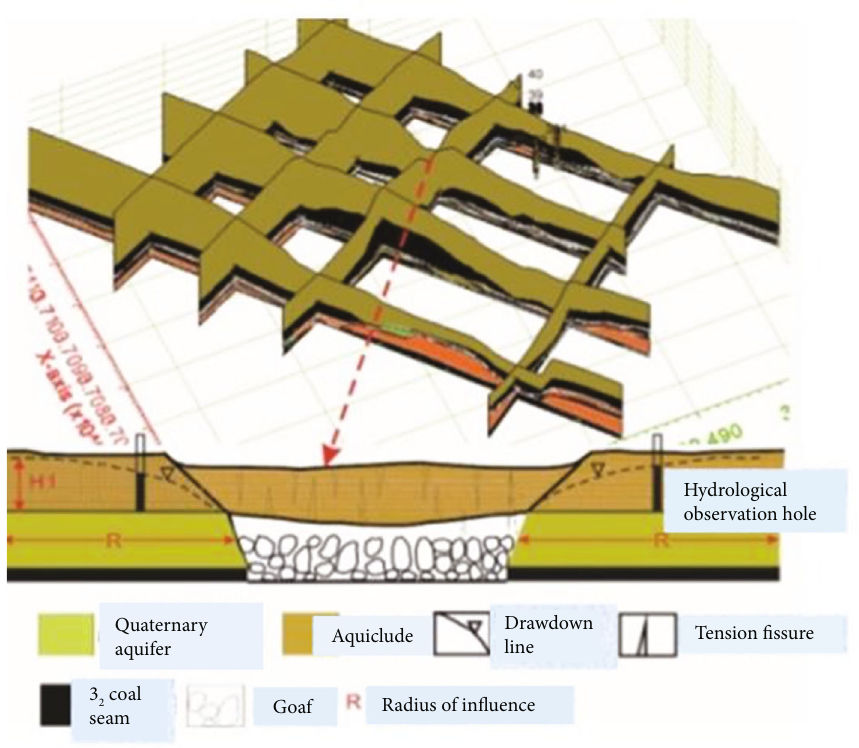
Figure 9: In fl uence of 3 coal seam mining on water level of the quaternary 2